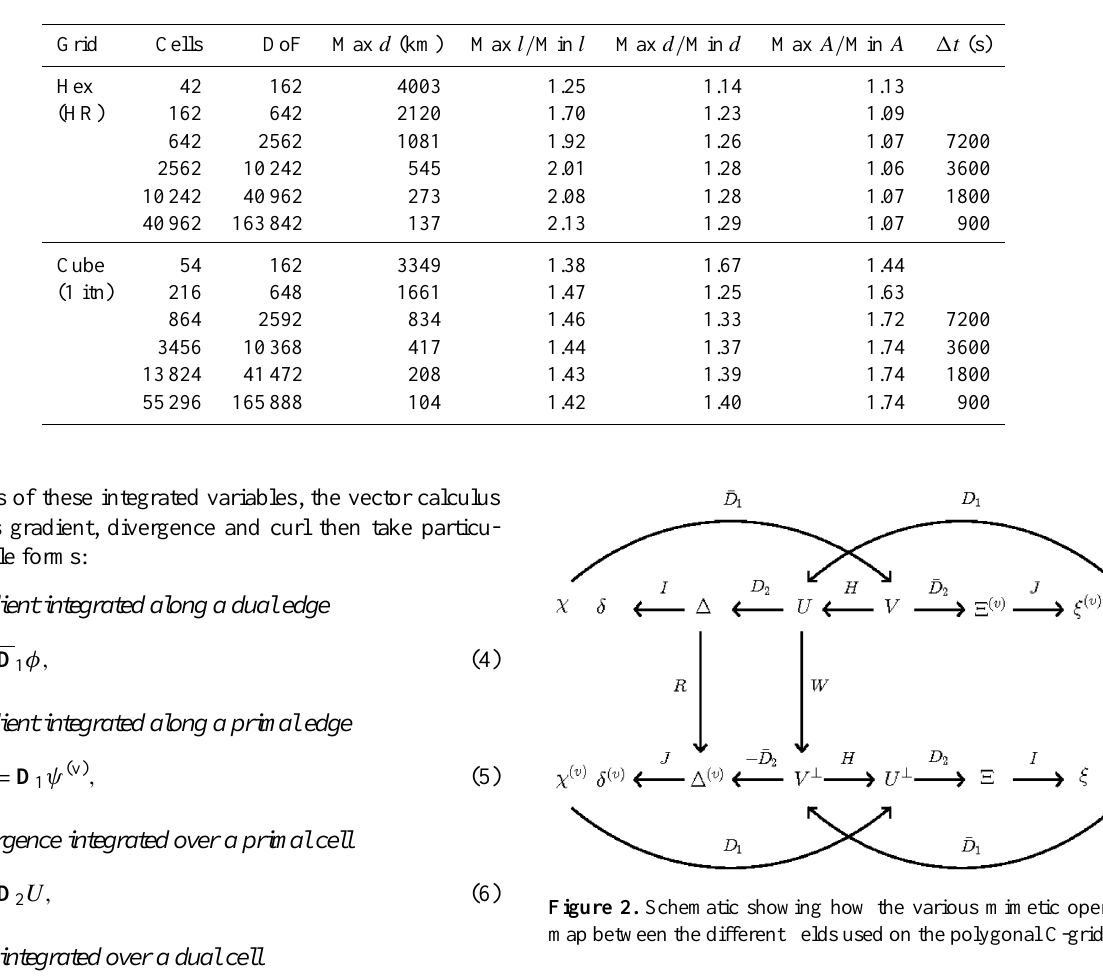
Table 1. Grid characteristics. The second to seventh columns give number of cells, total number of degrees of freedom (cells plus edges), maximum dual edge length (i.e. distance between neighbouring cell centres – a guide to the resolution), the ratio of maximum to minimum primal edge length, the ratio of maximum to minimum dual edge length, and the ratio of maximum to minimum primal cell area; the last three give a guide to grid uniformity. The last column gives the time step used at each resolution in the advection and solid body rotation tests.